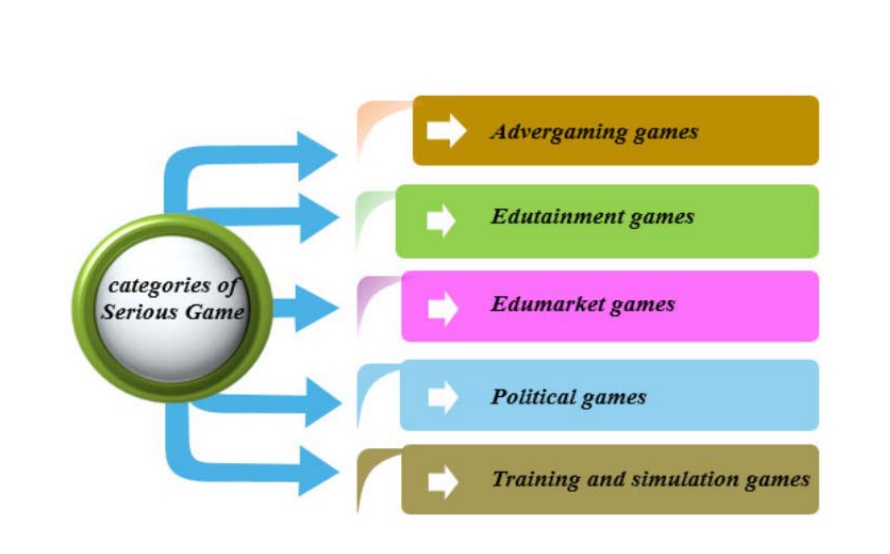
Figure 1 – Classification of serious games (Alvarez & Michaud, 2008) Рис . 1 – Классификация серьезных игр (Alvarez & Michaud, 2008) Слика 1 – Подела озбиљних игара (Alvarez & Michaud,